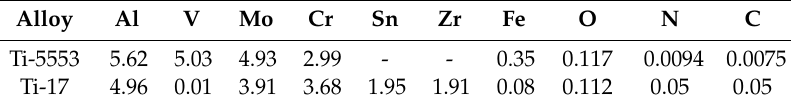
Table 1. Chemical composition of the investigated Ti-5553 and Ti-17 alloys (wt. %). Alloy